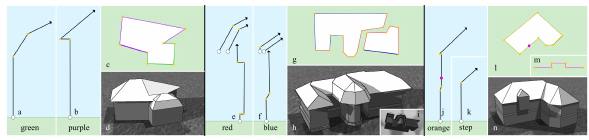
Figure 1: The work of T OM K ELLY and P ETER W ONKA (2011) offers a framework to specify the geometry of a building by ex- trusion profiles. The segments of footprint polygons ( c ) are asso- ciated with extrusion profiles - the green segments are associated to the profile a , the purple segments to the profile b . The resulting geometry can be seen in d .